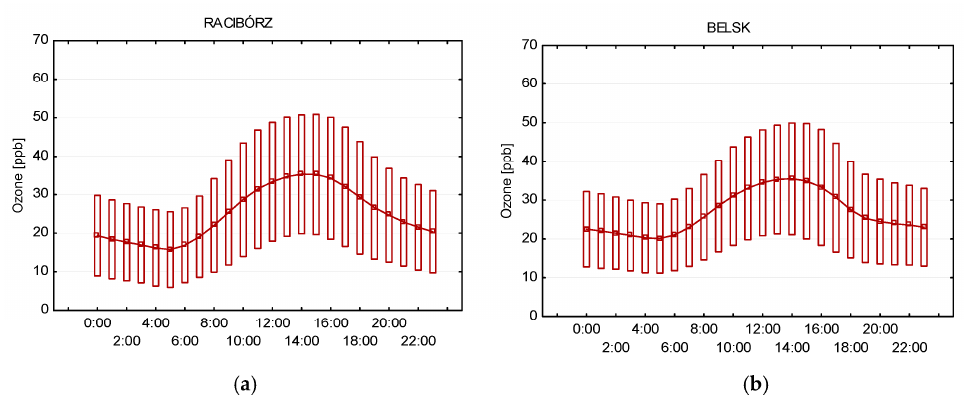
Figure 3. Mean daily course of surface O 3 from observations for the period from 2018 to 2021 in Racibórz ( a ) and at Belsk ( b ). The point shows the mean value, and the box displays the range: mean ± 1 standard deviation.